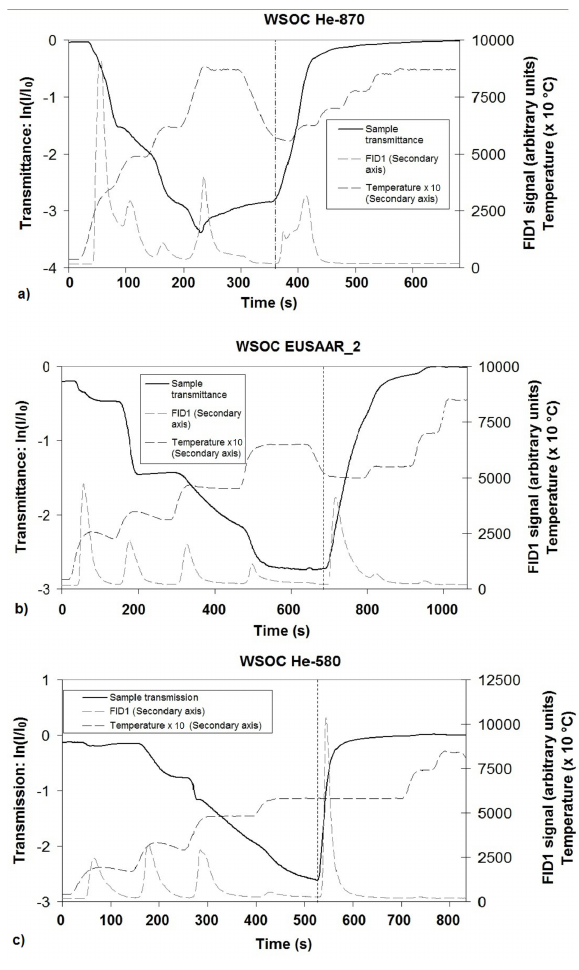
Fig. 5. WSOC thermograms obtained by He-870 (a) , EUSAAR 2 (b) , and He-580 (c) . The vertical line indicates the switch between He and He/O 2 atmosphere.